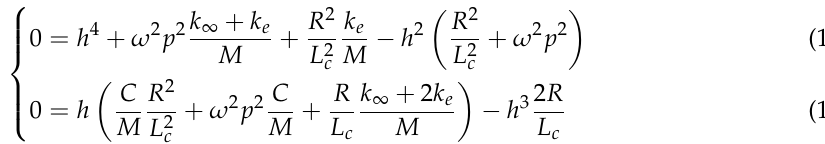
Figure 4. Root locus: Spin speeds corresponding to intersections with the imaginary